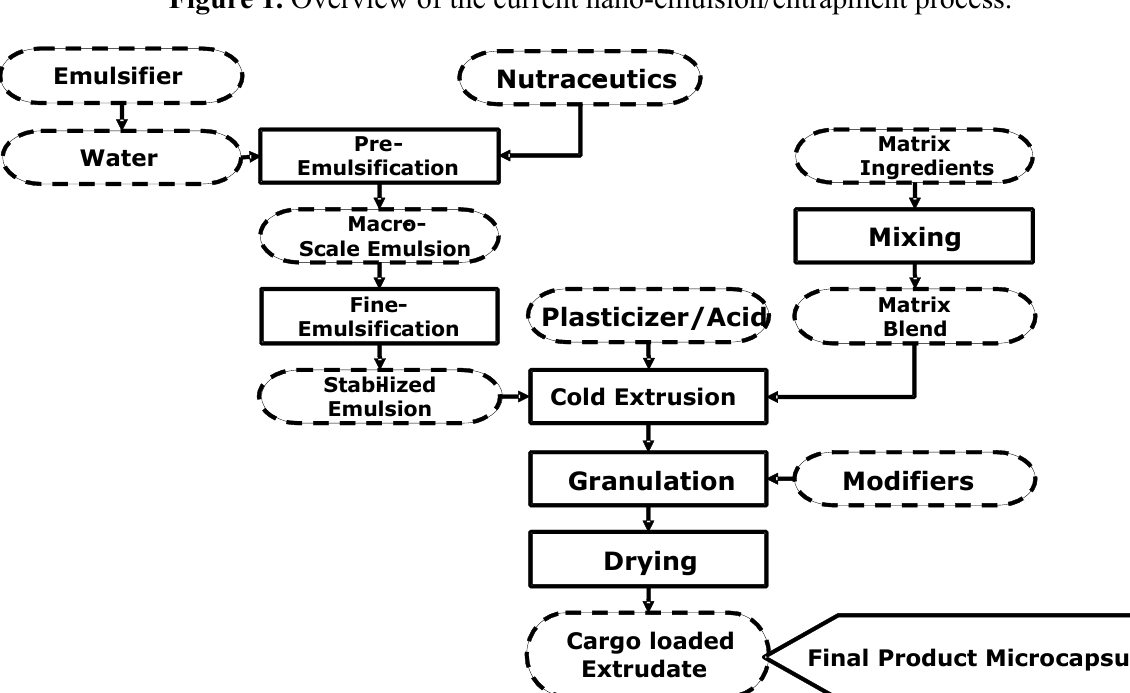
Figure 1. Overview of the current nano-emulsion/entrapment